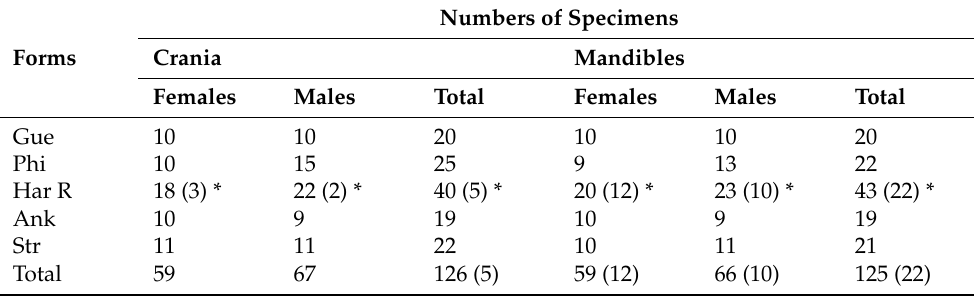
Table 1. Number of specimens obtained from DEZ (indicated with an asterisk symbol) and ZIN collections in each dataset used in the statistical analysis of various forms of the “guentheri” group (numbers of excluded specimens during statistical analysis of GM data are indicated in